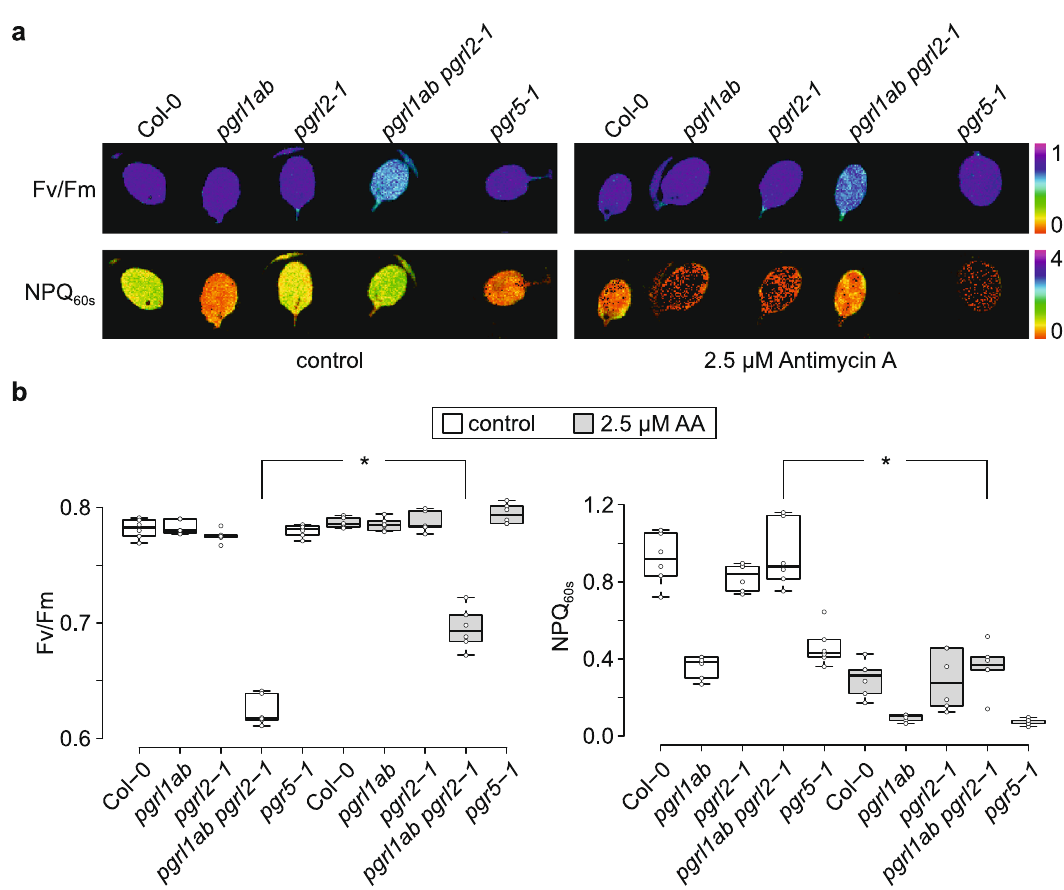
Fig. 7 PGRL1 is not the target of antimycin A (AA) in planta. a The effect of AA on maximum quantum yield of PSII (Fv/Fm) and transient non- photochemical quenching (NPQ) was examined by Imaging PAM analyses. Leaves were in fi ltrated with 2.5 µ M AA, dark-exposed for 5 min and subjected to Chl a fl uorescence analysis. After an initial saturating blue light pulse for Fv/Fm determination, actinic blue light was switched on and further saturating light pulses were applied every 20 s. Transient NPQ values were recorded 60 s after light induction. Fv/Fm and NPQ of in fi ltrated, detached leaves are depicted on a false-color scale ranging from 0 to 1 and 0 to 4, respectively. b Boxplot analyses of Fv/Fm and NPQ values shown in panel a. Open circles represent data from six leaves, treated either with in fi ltration medium alone or supplemented with AA. The horizontal lines represent the median, and boxes indicate the 25th and 75th percentiles. Whiskers extend 1.5× the interquartile range, outliers are represented as dots. The effect of AA on pgrl1ab pgrl2-1 was tested in a paired sample T-test (two-sided). Statistically signi fi cant differences are marked with asterisks (* p ≤ 0.05). The exact p -values are 4.6 × 10 − 7 and 3.0 × 10 − 3 in the left and right panel,